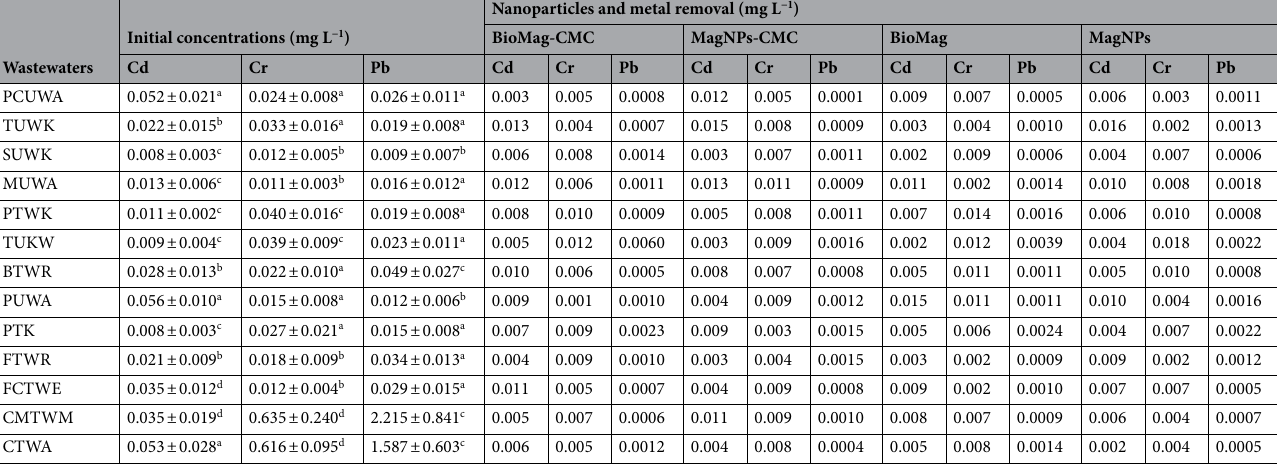
Table 5. Concentrations of the metals in the wastewater after remediation with the synthesized